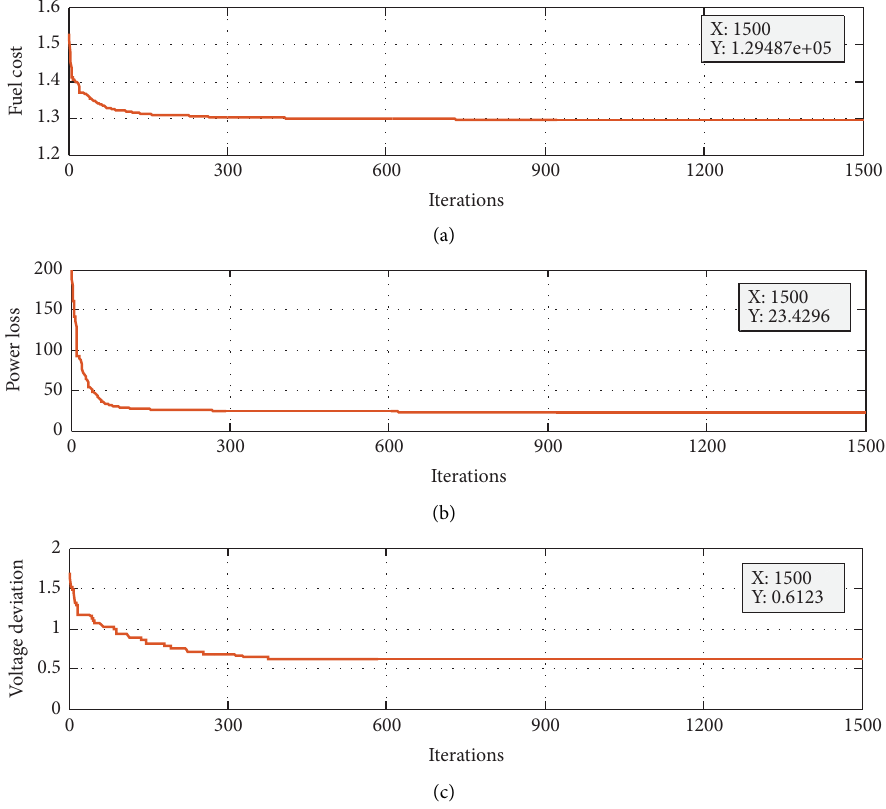
Figure 15: Convergence characteristic curves for single-objective OPF (Case 29 through Case 31) of the IEEE 118-bus system: (a) Case 29; (b) Case 30; (c) Case